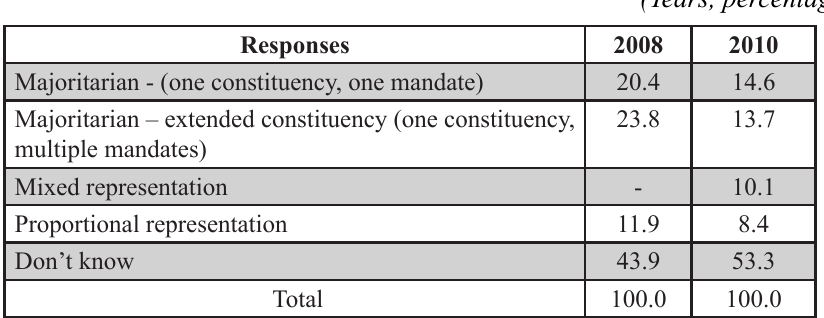
Table 5. What kind of electoral system is suitable for